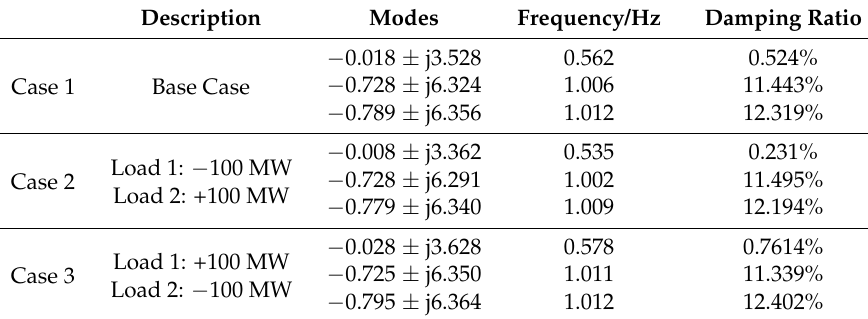
Table 2. Modes Characteristics under three different cases.